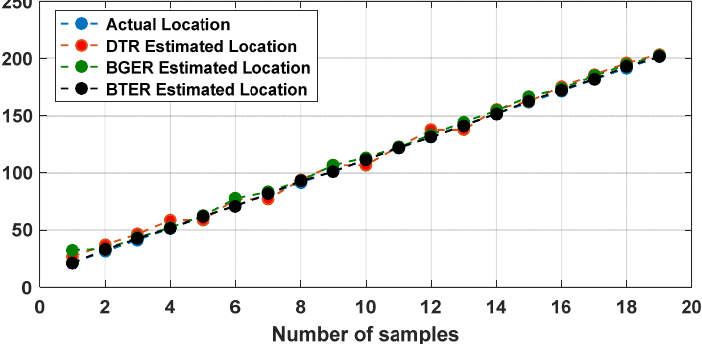
Figure 12. Actual and estimated fault locations for all the three methods during P1G fault.